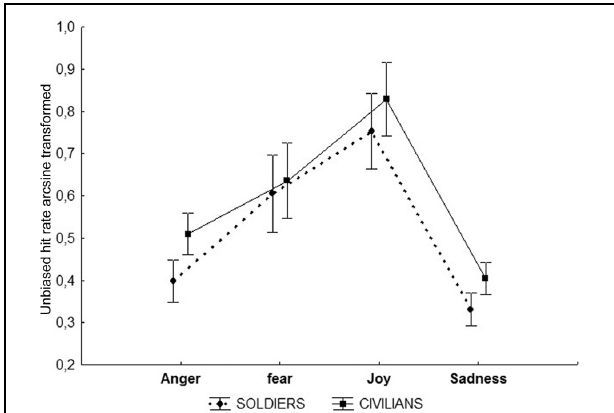
FIGURE 3 | Plots show the accuracy index of the two groups of participants for each emotion.